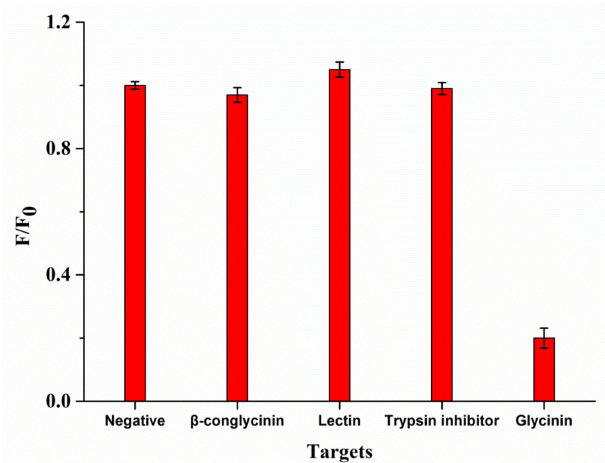
Figure 5. Specificity of QBs-FLISA. The concentration of glycinin is 0.62 µ g mL − 1 . The concentrations of β -conglycinin, trypsin inhibitor, and lectin were 20 µ g mL − 1